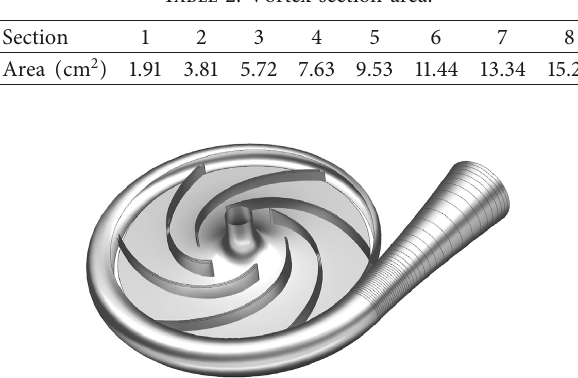
Figure 1: Centrifugal pump three-dimensional model.